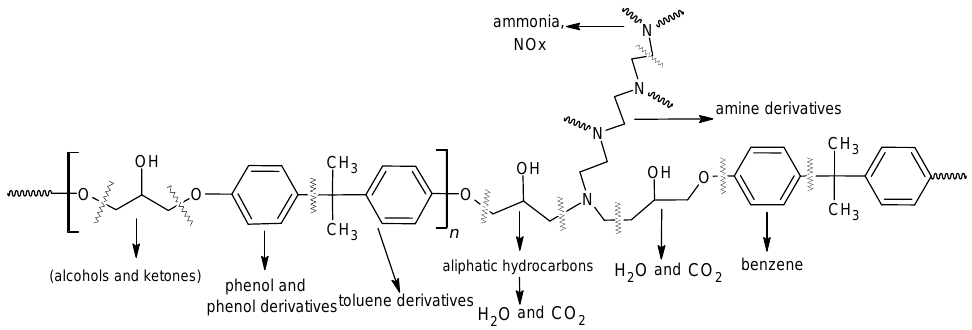
Figure 6. Proposal mechanisms of polymer fragmentation under heating.